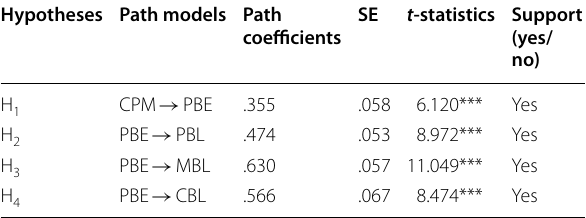
Table 4 Hypotheses, path coefficients and t